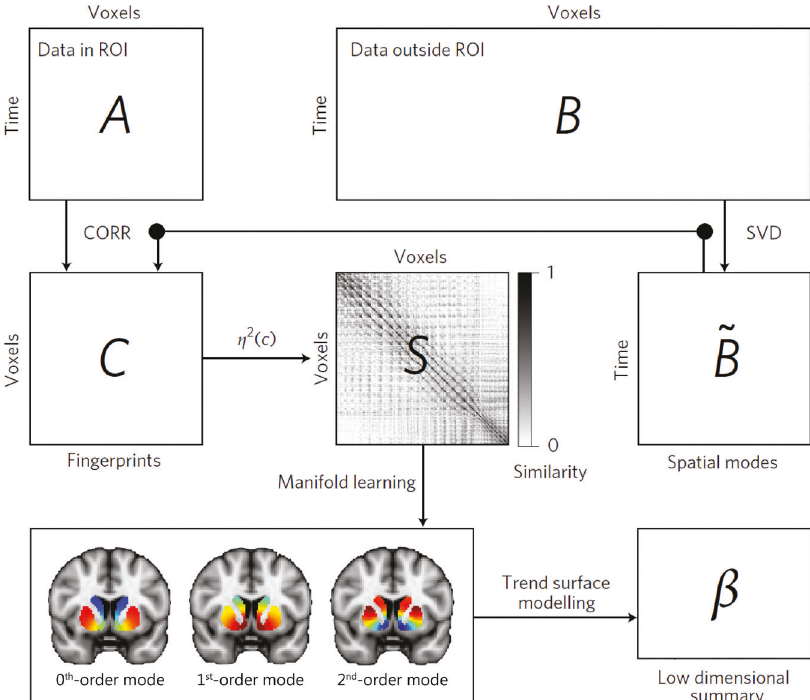
Fig. 1 The connectopic mapping pipeline. The fMRI voxelwise time-series from a pre-de fi ned striatal region-of-interest (ROI) are rearranged into a time-by-voxel matrix A , as are the time series from all voxels outside the ROI (matrix B ). The dimensionality of B is losslessly reduced using SVD, yielding ~ B . The connectivity fi ngerprint of every voxel within the ROI is computed as the Pearson ’ s correlation (CORR) between its time-series and the SVD-transformed data, yielding matrix C . The similarity in connectivity pro fi les between voxels is then quanti fi ed using the η 2 coef fi cient, resulting in matrix S . Laplacian eigenmap manifold learning is then used to yield a set of connection topographies or “ connectivity modes ” that together describe continuous spatial gradients in the functional organization of the striatum. Voxels that have similar colors in these connectivity modes have similar connectivity patterns with the rest of the brain, with red and blue colors indicating voxels that are maximally different from each other in terms of their connectivity pattern. Finally, trend surface modeling is applied to summarize the connectivity gradients by fi tting a set of trend coef fi cients ( β ) that optimally combine a set of spatial polynomial basis projections. Within this connectivity gradient, red voxels mapped onto quadratic, and cubic functions in the X , Y and Z direction of MNI152 high DAT availability (i.e., high density of dopaminergic projections) and coordinate space (9 TSM coef fi cients). The TSM coef fi cients of the fi tted blue voxels on low DAT availability (i.e., a low density of dopaminergic polynomial basis functions together describe the rate at which the gradient projections). We excluded 1 ≤ N ≤ 5 datasets for the fi rst-order mode and changes along a given spatial dimension and can be used for statistical 21 ≤ N ≤ 38 datasets for the second-order mode due to low quality (Table analysis. We excluded subjects with outlying values (de fi ned as 3 standard S7), with the numbers depending on the cohort (i.e., FEP or community) deviations beyond the mean) in one or more of the TSM coef fi cients and hemisphere (i.e., left or right). As in previous work [29], low data (0 ≤ N ≤ 3 individuals, depending on the speci fi c analysis). The polynomials summarized the connectivity modes well, explaining the following quality was de fi ned as a spatial correlation below 0.5 with the group- proportions of variance in the FEP dataset (mean ± SD): left striatum fi rst- average connectivity modes obtained in a prior analysis of the high-quality order mode: 88.65 ± 6.40%, right striatum fi rst-order mode: 87.93 ± 6.75%, HCP dataset (see Table 1; [29]). The higher number of excluded gradients left striatum second-order mode: 78.95 ± 7.73%, right striatum second- in the FEP compared to community dataset is inherent to the lower order mode: 78.51 ± 7.61%. Similar results were obtained for the schizotypy temporal and spatial resolution of the resting-state fMRI data in the FEP dataset: left striatum fi rst-order mode: 91.17 ± 3.56%, right striatum fi rst- dataset. Similarly, the higher number of exclusions for the second-order order mode: 91.25 ± 3.80%, left striatum second-order mode: gradient can be explained by the slightly lower stability of the second- 77.32 ± 5.82%, right striatum second-order mode: 78.52 ± 5.30%. In the order (compared to fi rst-order) gradient, which is masked by the supplementary material (pages 5 and 6) we further demonstrate the connectivity of the fi rst-order gradient. For more details, see [26, 29]. To enable statistical analysis over these connection topographies, we combined the connectivity modes obtained for putamen and caudate- NAcc and fi tted spatial statistical models in order to obtain a set of coef fi cients summarizing the fi rst-order and second-order spatial gradients in the X, Y and Z axes of the MNI152 coordinate space. More speci fi cally, we used trend surface modeling (TSM; [47]), which involves fi tting a set of polynomial basis functions de fi ned by the coordinates of each striatal location to predict each subject ’ s connection topography. We fi tted these models using Bayesian linear regression [48]. To select the degree of the interpolating polynomial basis set, we fi tted these models across polynomials of degrees ranging from 1 to 5 and then compared the different model orders using a Scree plot analysis [49]. This criterion strongly favored a polynomial of degree 3 for both the fi rst and second order connectivity modes, see Supplementary Figures S3 and S4. This and the group classi fi cation accuracy of tests that revealed signi fi cant means that the connectivity mode in striatum was modelled with linear,